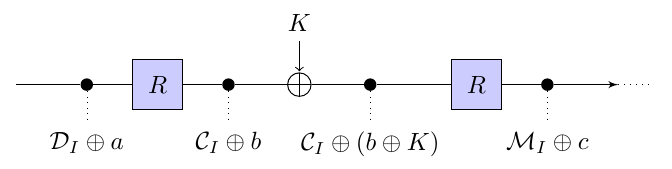
Figure 4: Subspaces over 2 rounds of